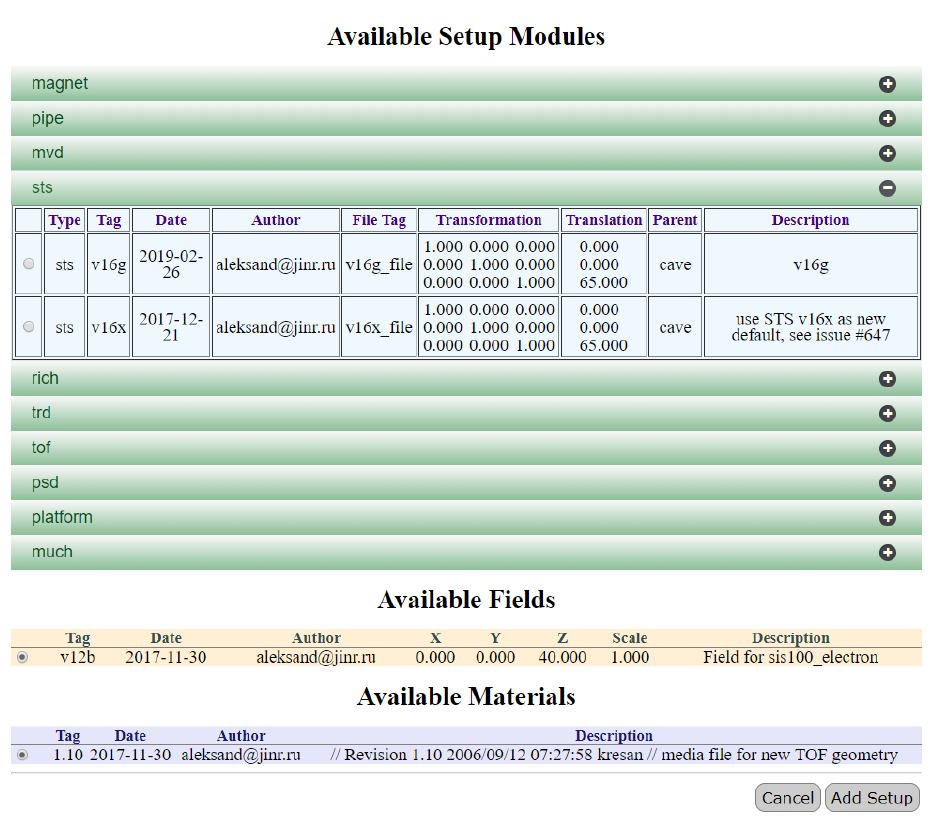
Fig. 7. Web-interface: Form for adding a new